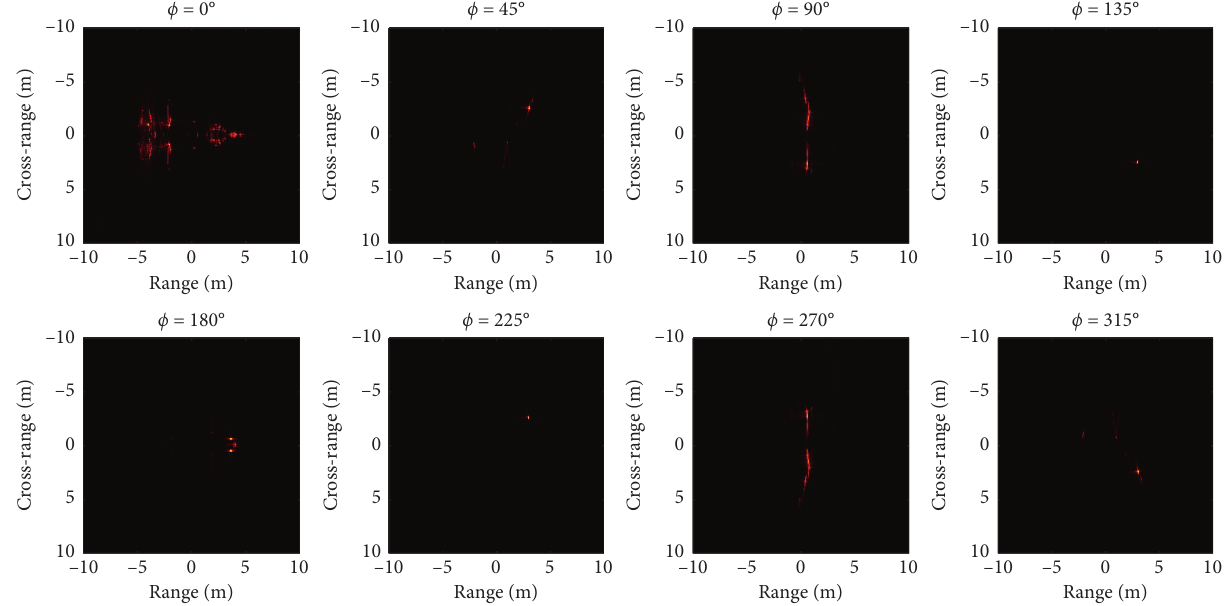
Figure 15: Subaperture images in different